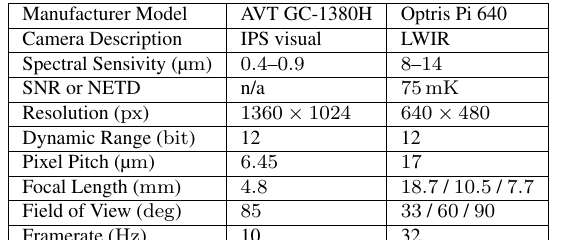
Figure 4. Exemplary images for thermal-colored 3D model generation. Left stereo-camera image (a), corresponding LWIR sensor image (b), and color code disparity image (c).